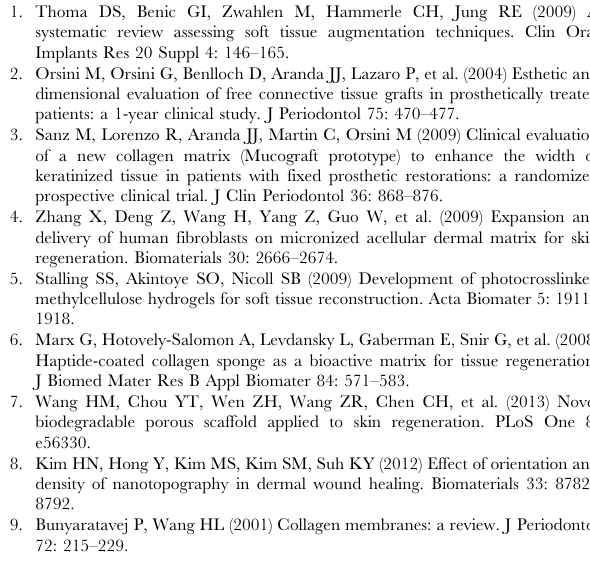
Table S6 Corresponding data on up-regulated genes. Table S6 shows the corresponding data of the up-regulated genes in figure 6. Table S7 Corresponding data on down-regulated genes. Table S7 shows the corresponding data of the down-regulated genes in figure